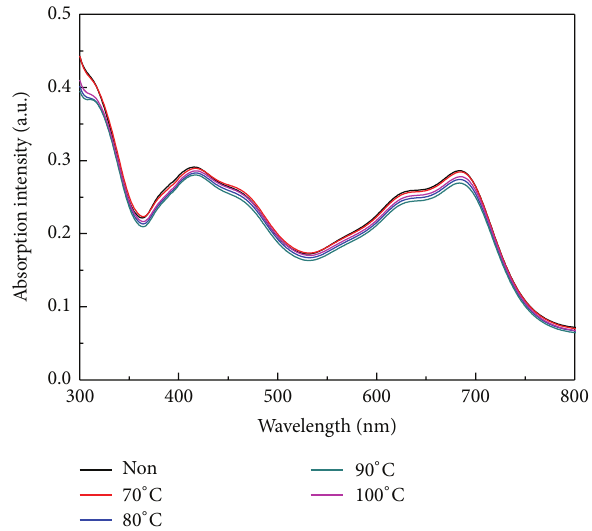
Figure 4: Absorption spectra of PBDTTT-C:PC 71 BM blend films heated under different temperatures for 5 minutes.